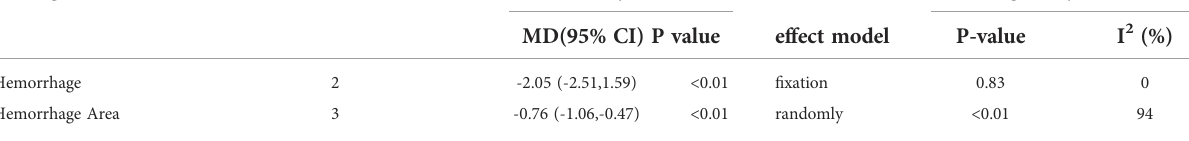
TABLE 3 Meta-analysis results of hemorrhagic.